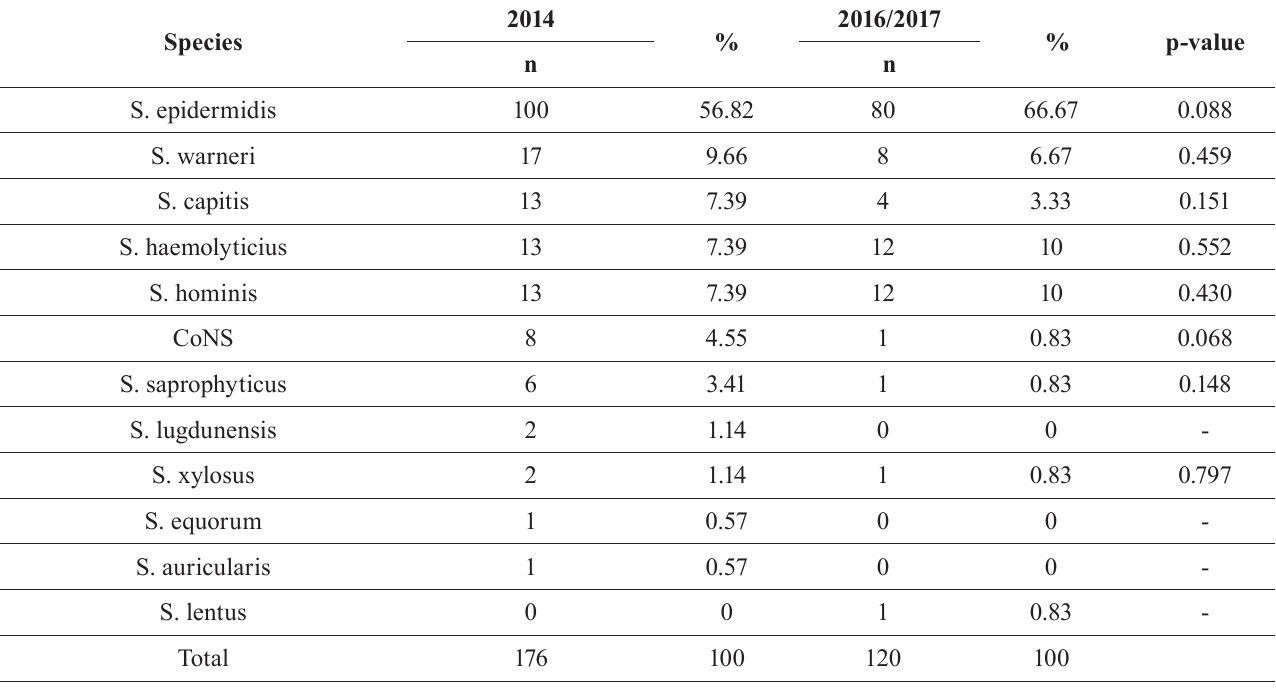
TABLE I – D istribution of coagulase-negative staphylococci (CoNS) species isolated from blood cultures of newborns in 2014 and 2016/2017 in a tertiary hospital in southern Brazil